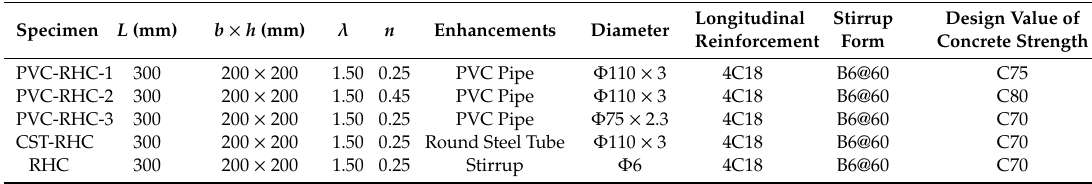
Table 1. Parameters of